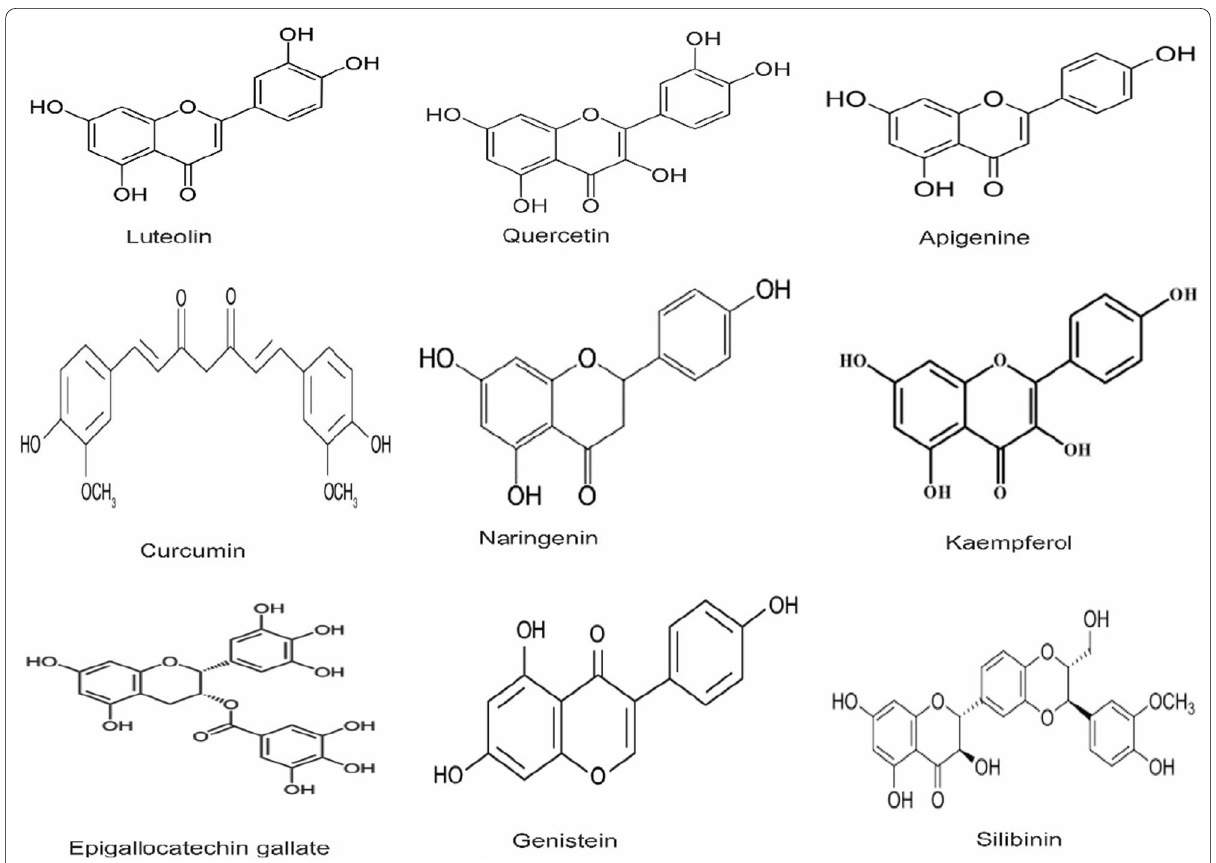
Fig. 4 Chemical structure of selected